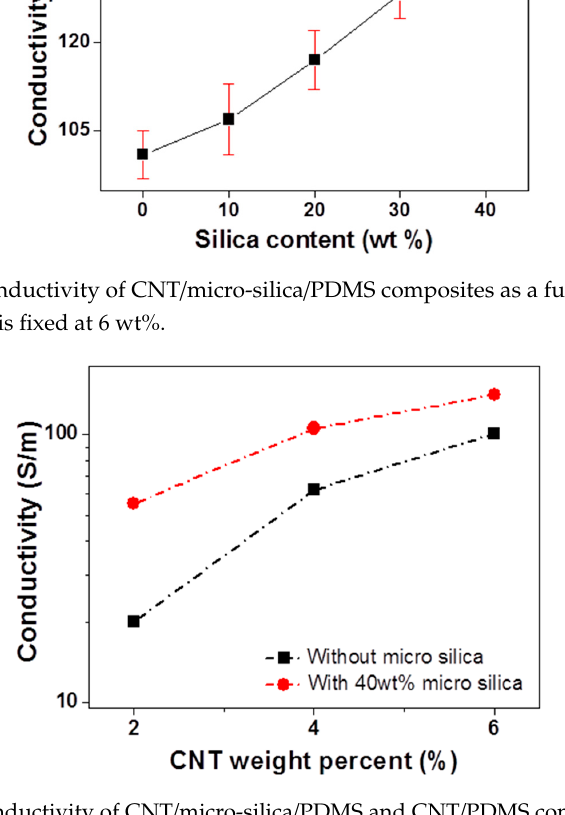
Figure 6. Electrical conductivity of CNT/micro-silica/PDMS and CNT/PDMS composites as a function